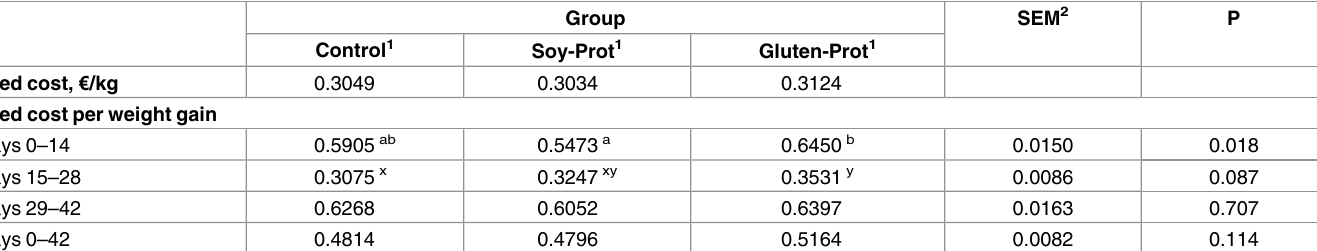
The results for microbial populations in the ileum and the cecum are shown in Table 8. Densi- ties of the quantified bands expressed in arbitrary units (AU) reflect to the amount of genetic material of each of the 4 pathogens that was detected by PCR in our study. In the ileum, DNA from C . perfringens was detected in statistically lower AU in the Gluten-Prot group compared to the other groups. Furthermore, both DNA from C . perfringens and F . necrophorum were also statistically lower in cecum in both groups supplemented with protease and fed lower pro- tein levels compared to control group. No significant differences were noted for Lactobacillous spp. and E . Coli in either ileum or cecum among the experimental groups.